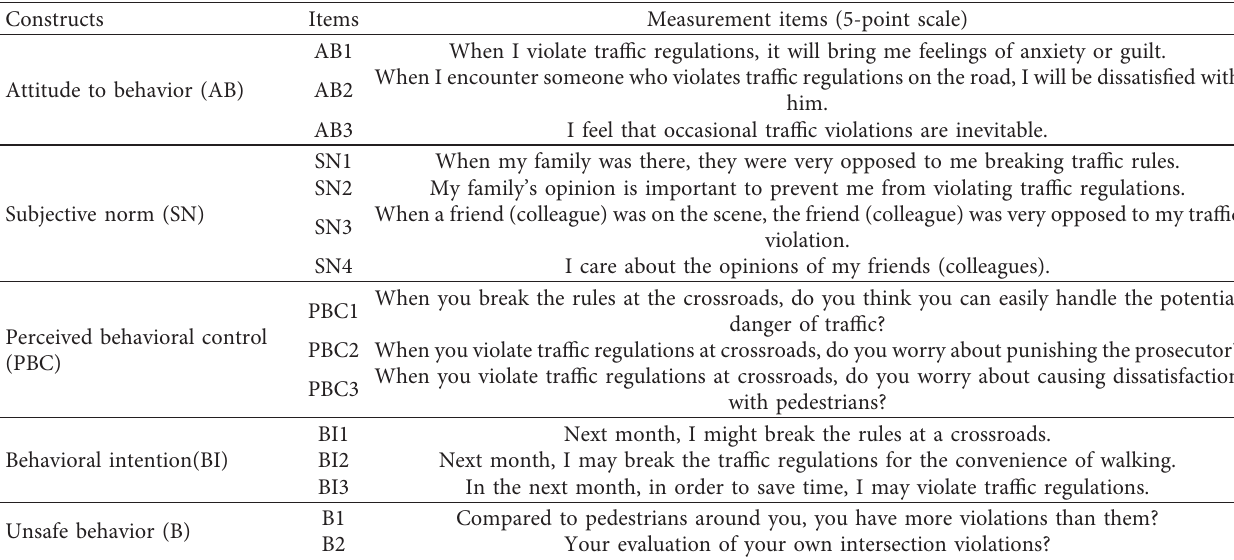
Table 1: Questionnaire items.